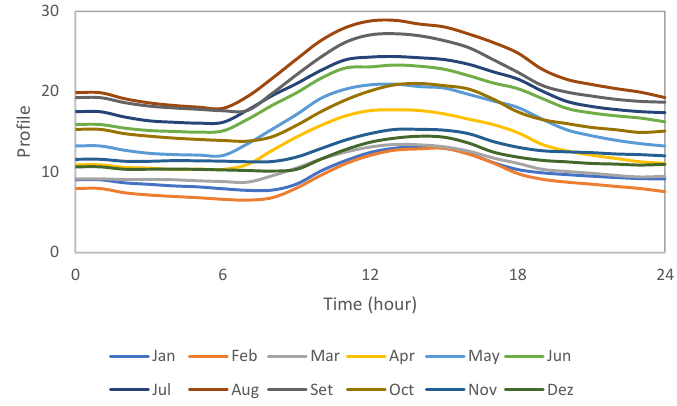
Figure A3. Average daily temperature profiles, per